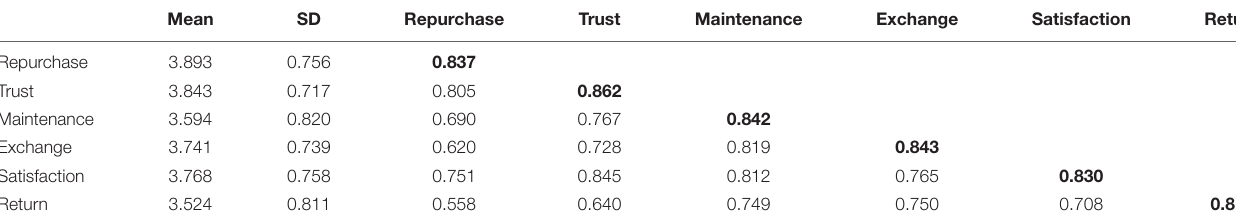
TABLE 5 | Discriminant validity of the constructs, mean, and standard